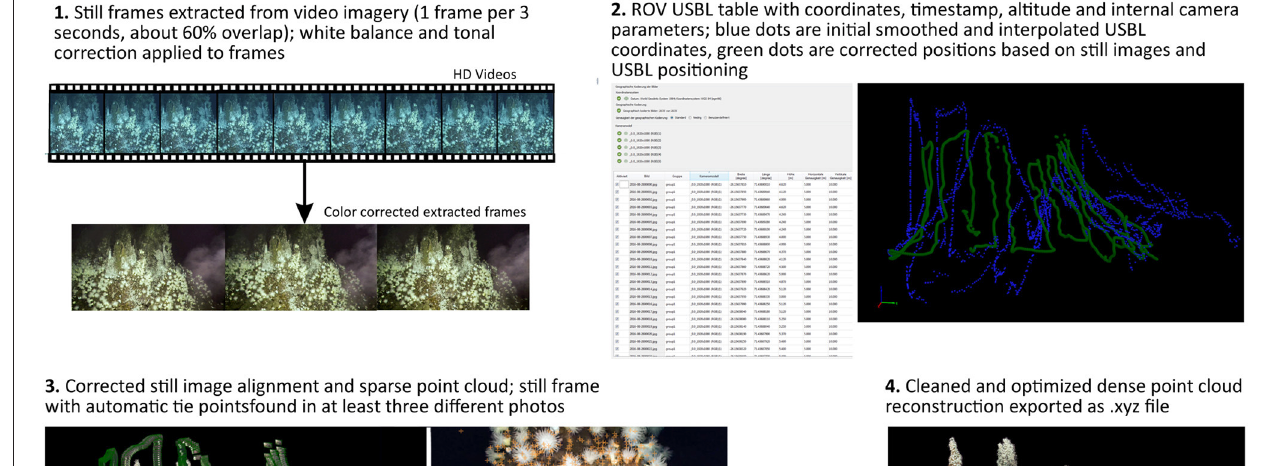
Single individuals were sampled to verify the imagery based identification of all counted taxa at the vent